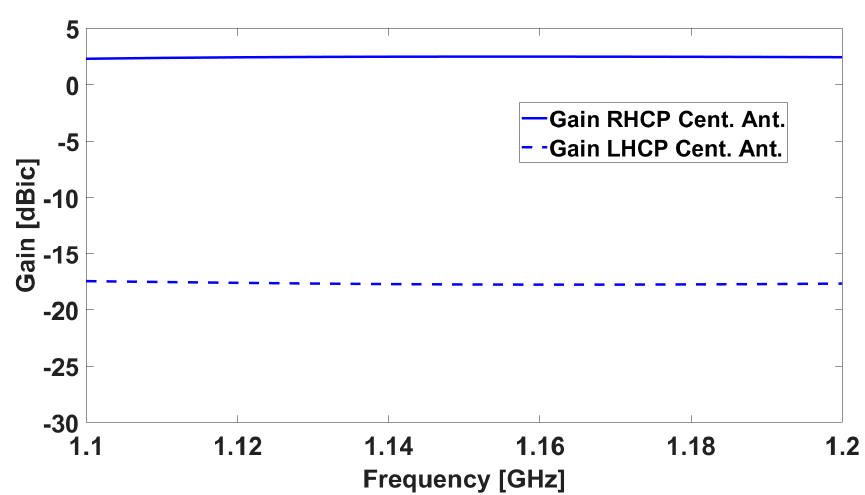
Figure 2. Simulated realized gain for the central antenna element: the solid line is the RHCP, while the dotted line is the Left Hand Circular Polarization (LHCP).